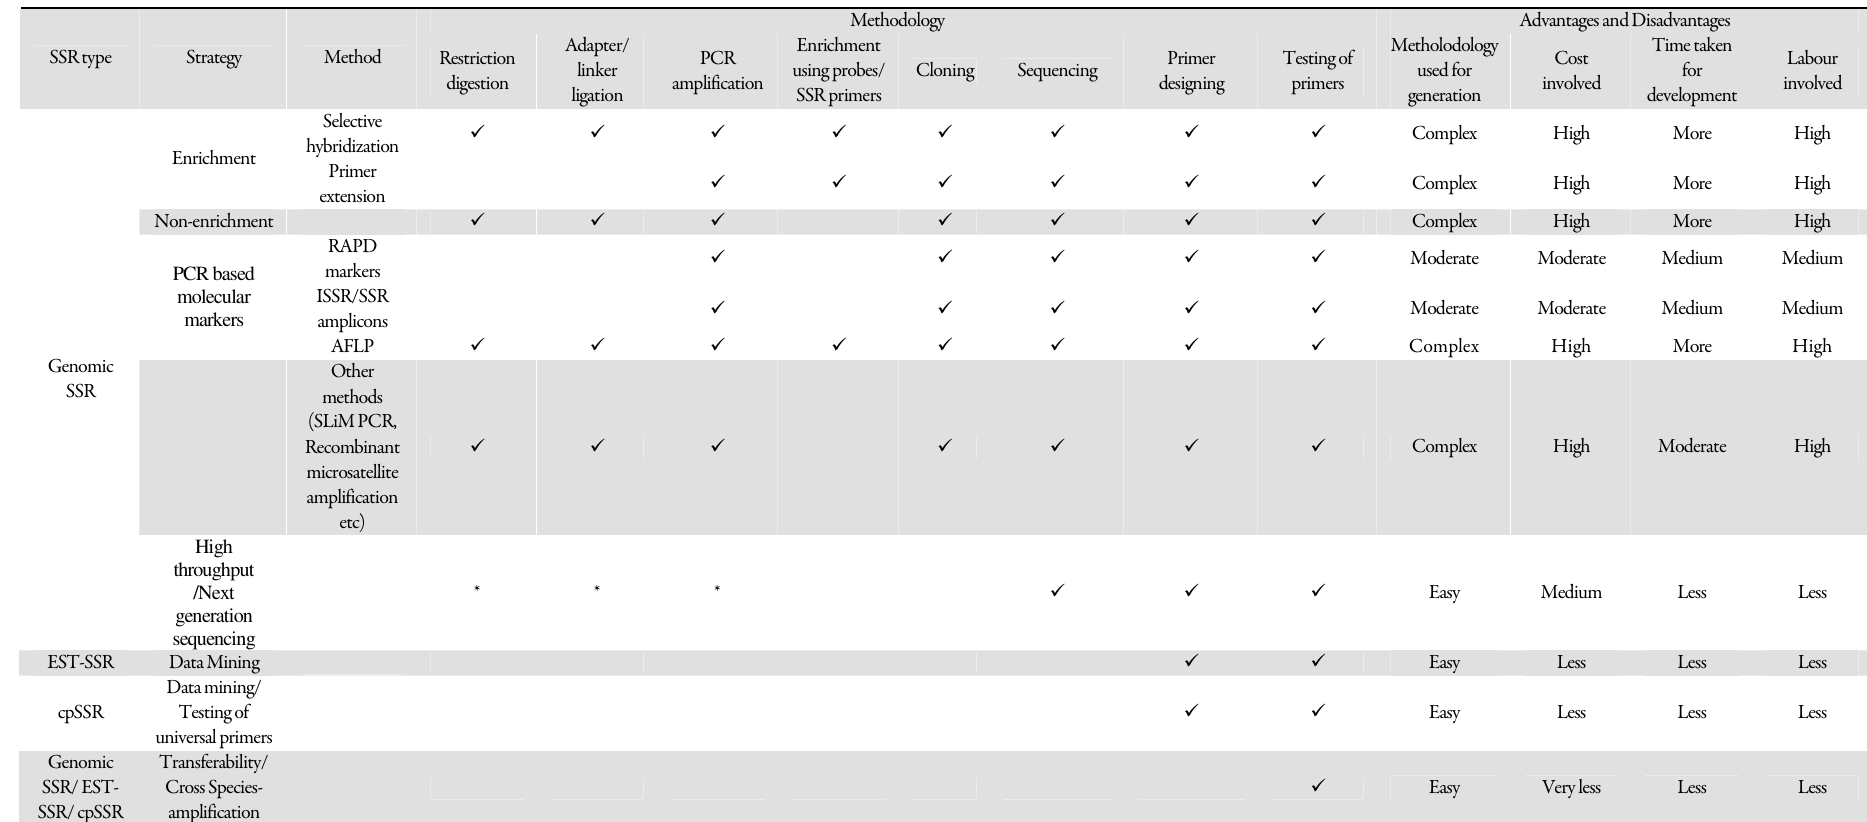
Tab. 1. Comparison of different methods used for the development of microsatellite